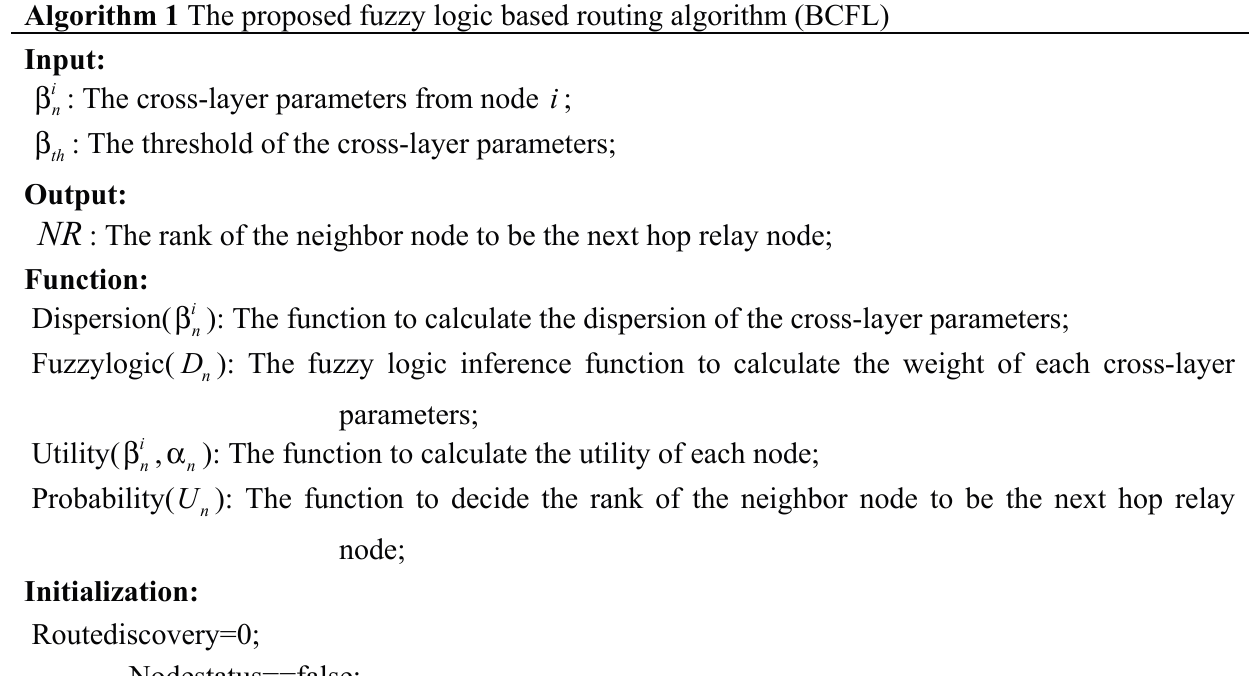
Algorithm 1 The proposed fuzzy logic based routing algorithm